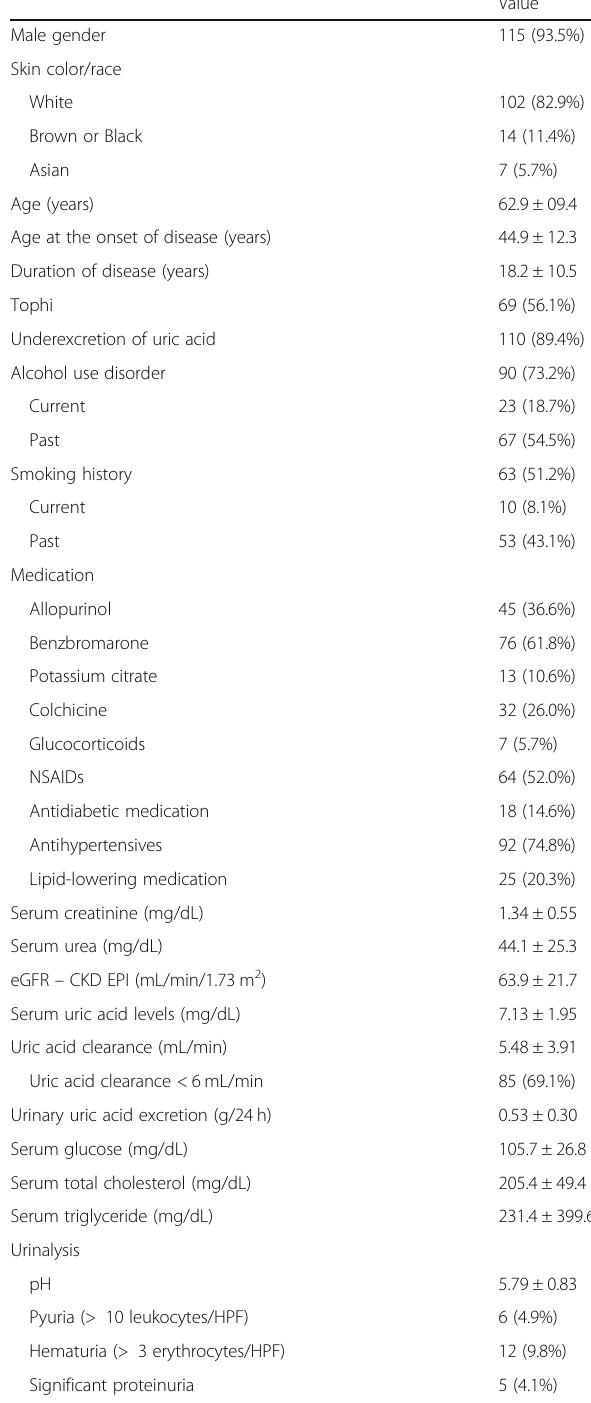
Table 1 Clinical and laboratory features of 123 Brazilian patients with primary